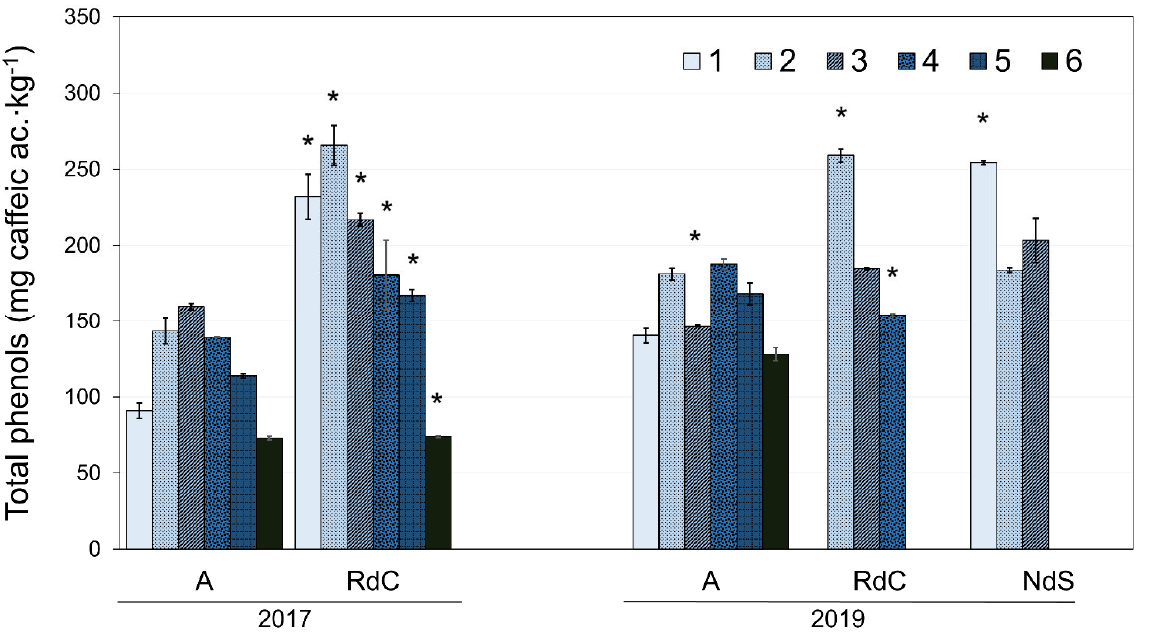
Figure 4. Evolution of polyphenol content for “Arbequina” (A), “Royal de Calatayud” (RdC), and “Negral de Sabiñán” (NdS) olive oils in 2017 and 2019 crop years. Harvest dates: 1 (1–4 October), 2 (16–18 October), 3 (28 October–7 November), 4 (11–22 November), 5 (25–29 November), and 6 (11–13 December). *, significant statistical differences ( p < 0.05) among cultivars for the same crop year.